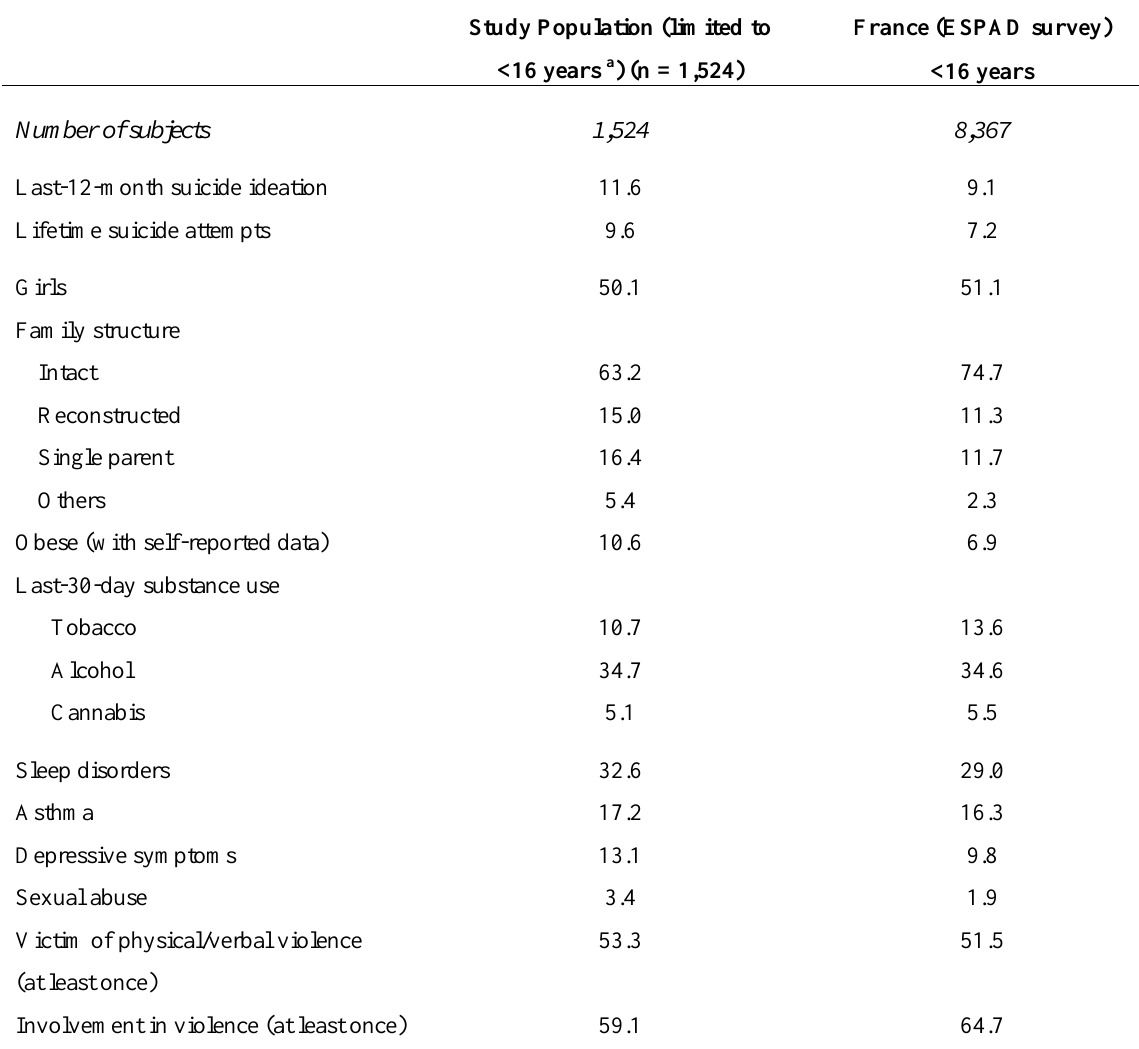
Table A1. Comparison between the study population and France (ESPAD survey [3,4]):